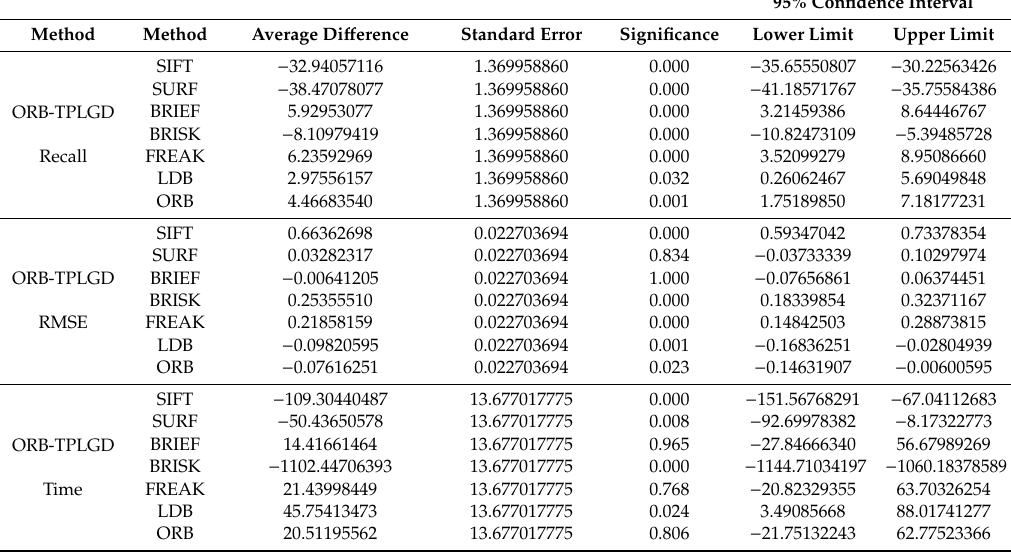
Table 13. Tukey test result of ORB-TPLGD part for recall, RMSE, and matching